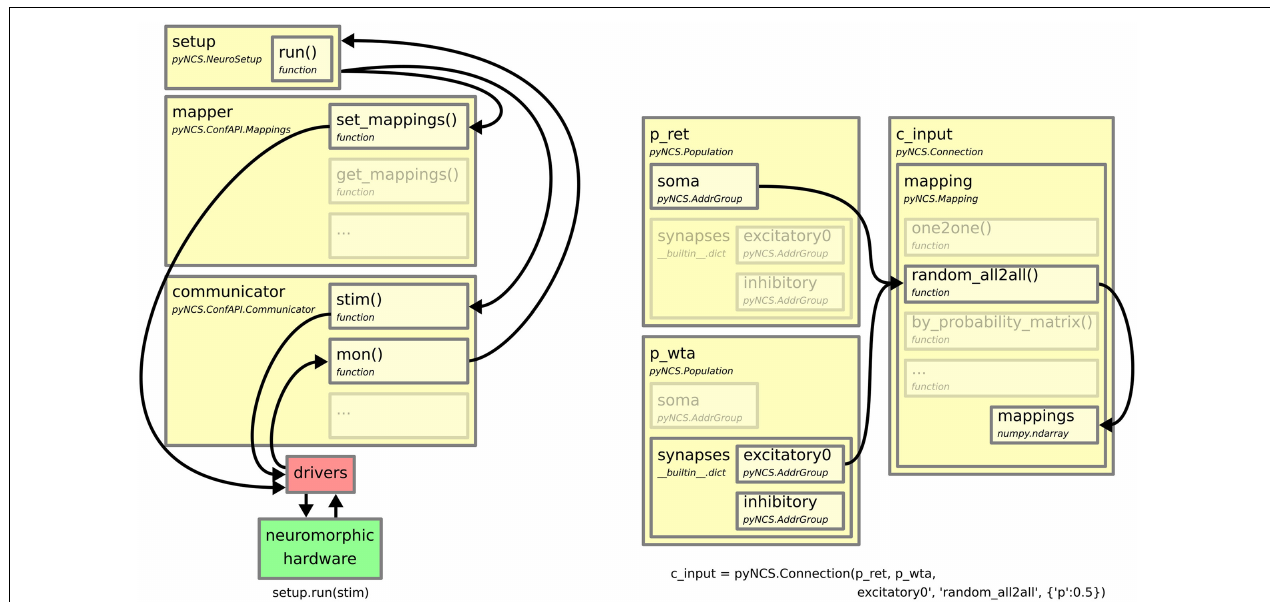
FIGURE 2 | Left: Dataflow of an experiment run. The setup.run function configures the routers according to the network topology, defined as a map between source addresses and destination addresses, and sends the stimulus to the chips calling methods of the configurator and communicator APIs. These APIs implement calls to the custom drivers for communicate with the hardware. The communicator API monitors the spiking activity which is then collected by the run function. The arrows represent the data flow. Right: Constructing a connection between two populations, the p_ret and the p_wta , which